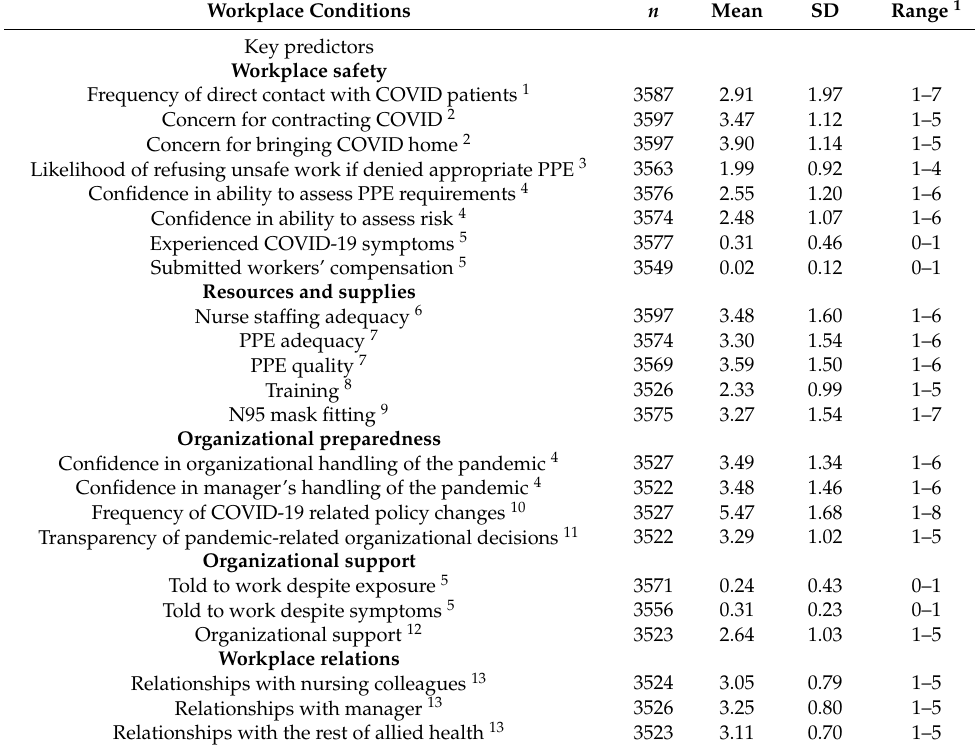
Table 2. Descriptive statistics for key workplace condition